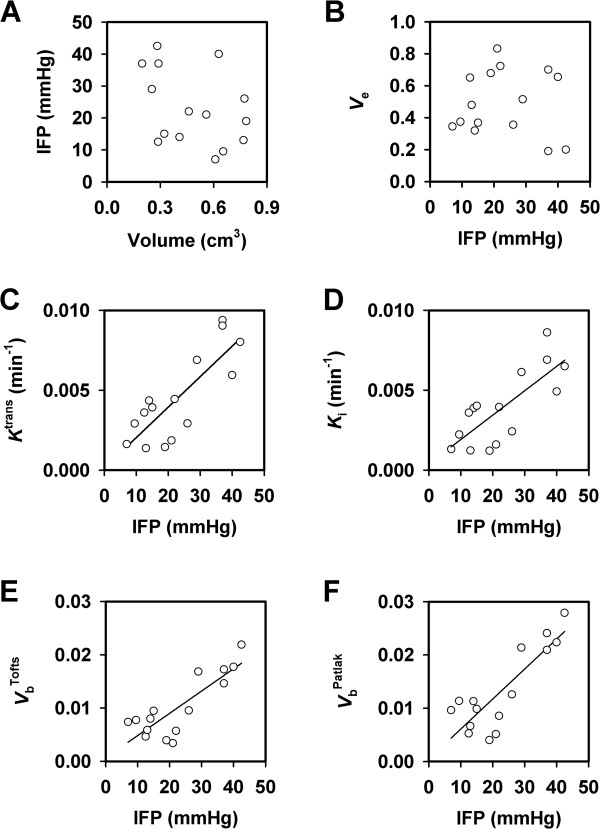
DCE-MRI and IFP data for CK-160 cervical carcinoma xenografts imaged with gadomelitol as contrast agent. (A) IFP versus tumor volume. (B) Median veversus IFP. (C) Median Ktransversus IFP. (D) Median Kiversus IFP. (E) Median VbToftsversus IFP. (F) Median VbPatlakversus IFP. The points represent single tumors. The curves were fitted to the data by linear regression analysis.